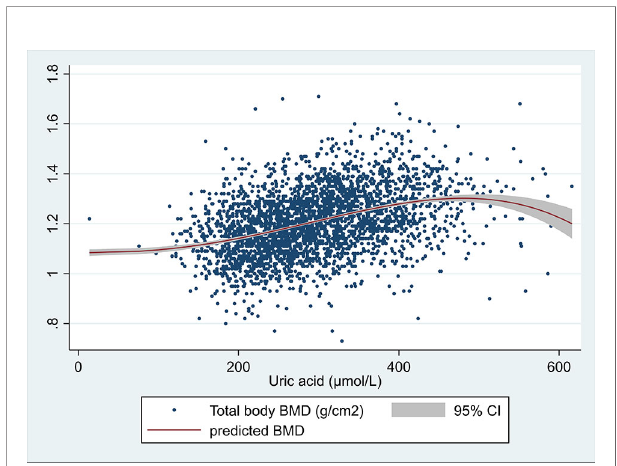
FIGURE 1 | Scatter plot of serum uric acid (µmol/L) and total body BMD (g/cm 2 ). The unadjusted prediction was made using the fractional polynomial method. One outlier was removed (total BMD